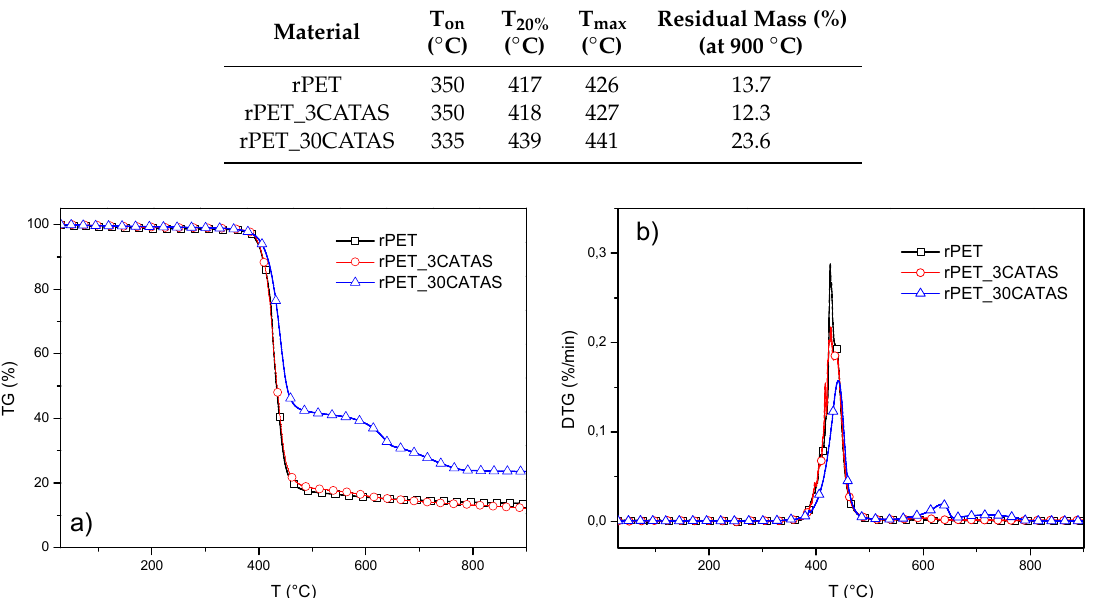
Figure 7. TG curve ( a ) and DTG curve ( b ) for rPET and rPET/CATAS nanocomposites at 3 and 30 wt. % of CATAS. Table 4. TGA parameters of rPET_CATAS nanocomposites at three representative loading levels (0, 3 and 30 wt. %).